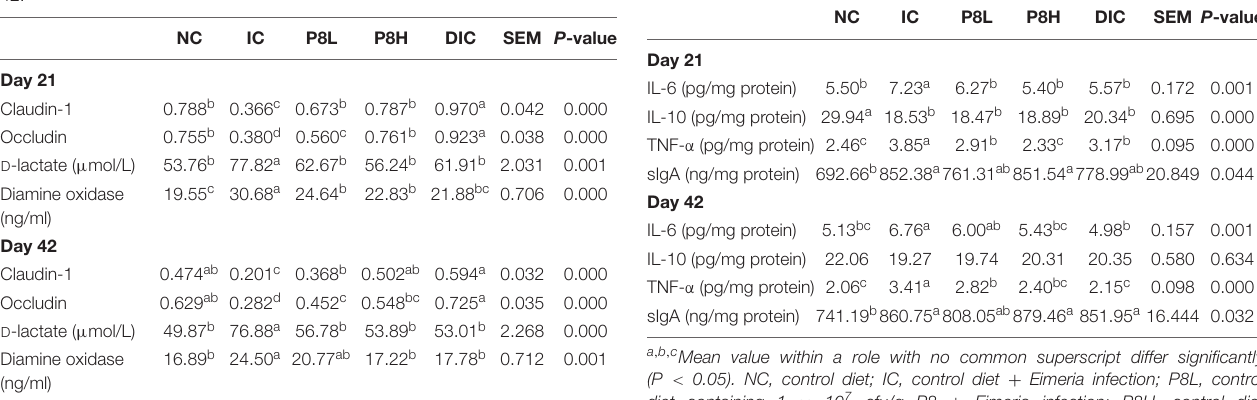
TABLE 5 | Effects of P8 on the expressions of intestinal tight junction proteins and levels of D -lactate and diamine oxidase of Eimeria -infected broilers at days 21 and 42.